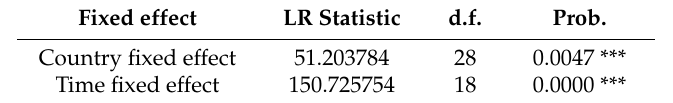
Table 7. Combined significance test results of province and time fixed effects for absolute convergence.